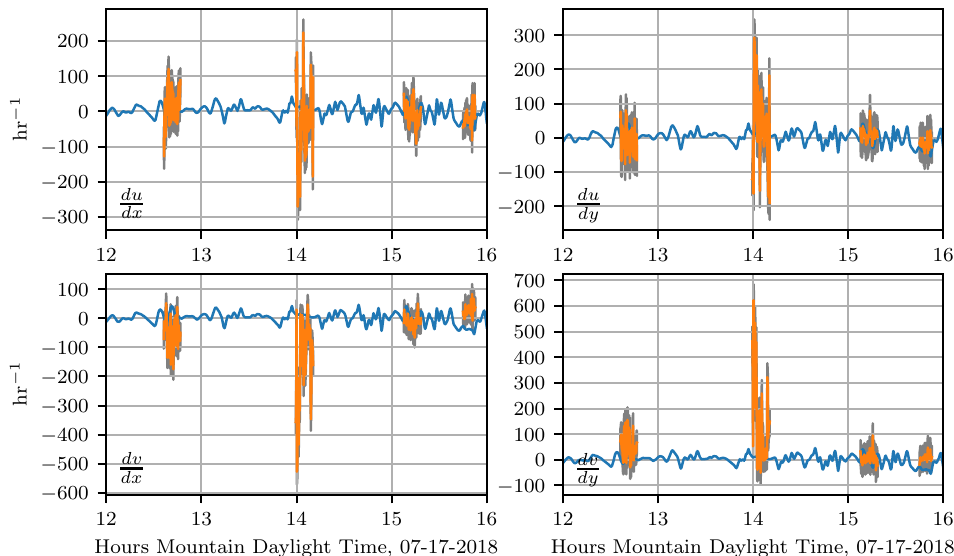
Figure 15. The velocity gradient from WRF-LES predictions (blue) and the velocity gradient as calculated from sensor measurements (orange). The velocity gradient from the WRF-LES comes from the 10 m height level wind speed, while wind speed measurements used to calculate the velocity gradient were performed by sensors at 15 m. The uncertainty ranges for the velocity gradient as calculated from sensor measurements are shown in